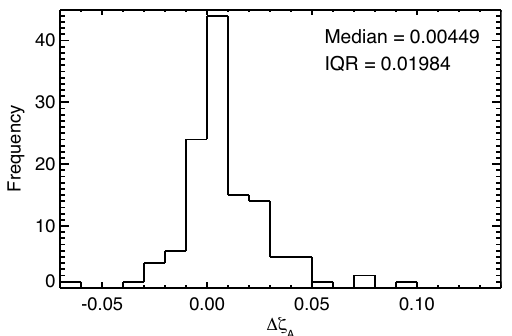
Figure 4. Difference in domain-averaged cloud cover ( (cid:49)C A ) be- tween the single-band threshold reported by Zhao and Di Girolamo (2006) and the new ASTER cloud masking scheme. Data were sam- pled over 124 broken cumulus scenes in the tropical southern At- lantic Ocean. Values for the median and interquartile range (IQR) are